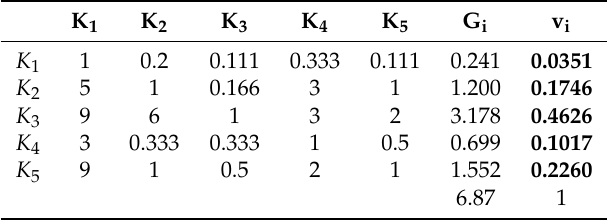
Table 3. Saaty matrix with geometric means calculated, and standardized weights of the individual criteria. K 1 K 2 K 3 K 4 K 5 G i v i K 1 1 0.2 0.111